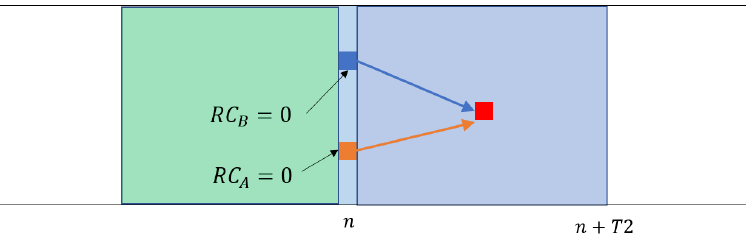
Figure 3. SPS sensing prevents the collision of the planned moves if RCs expire in different subframes.